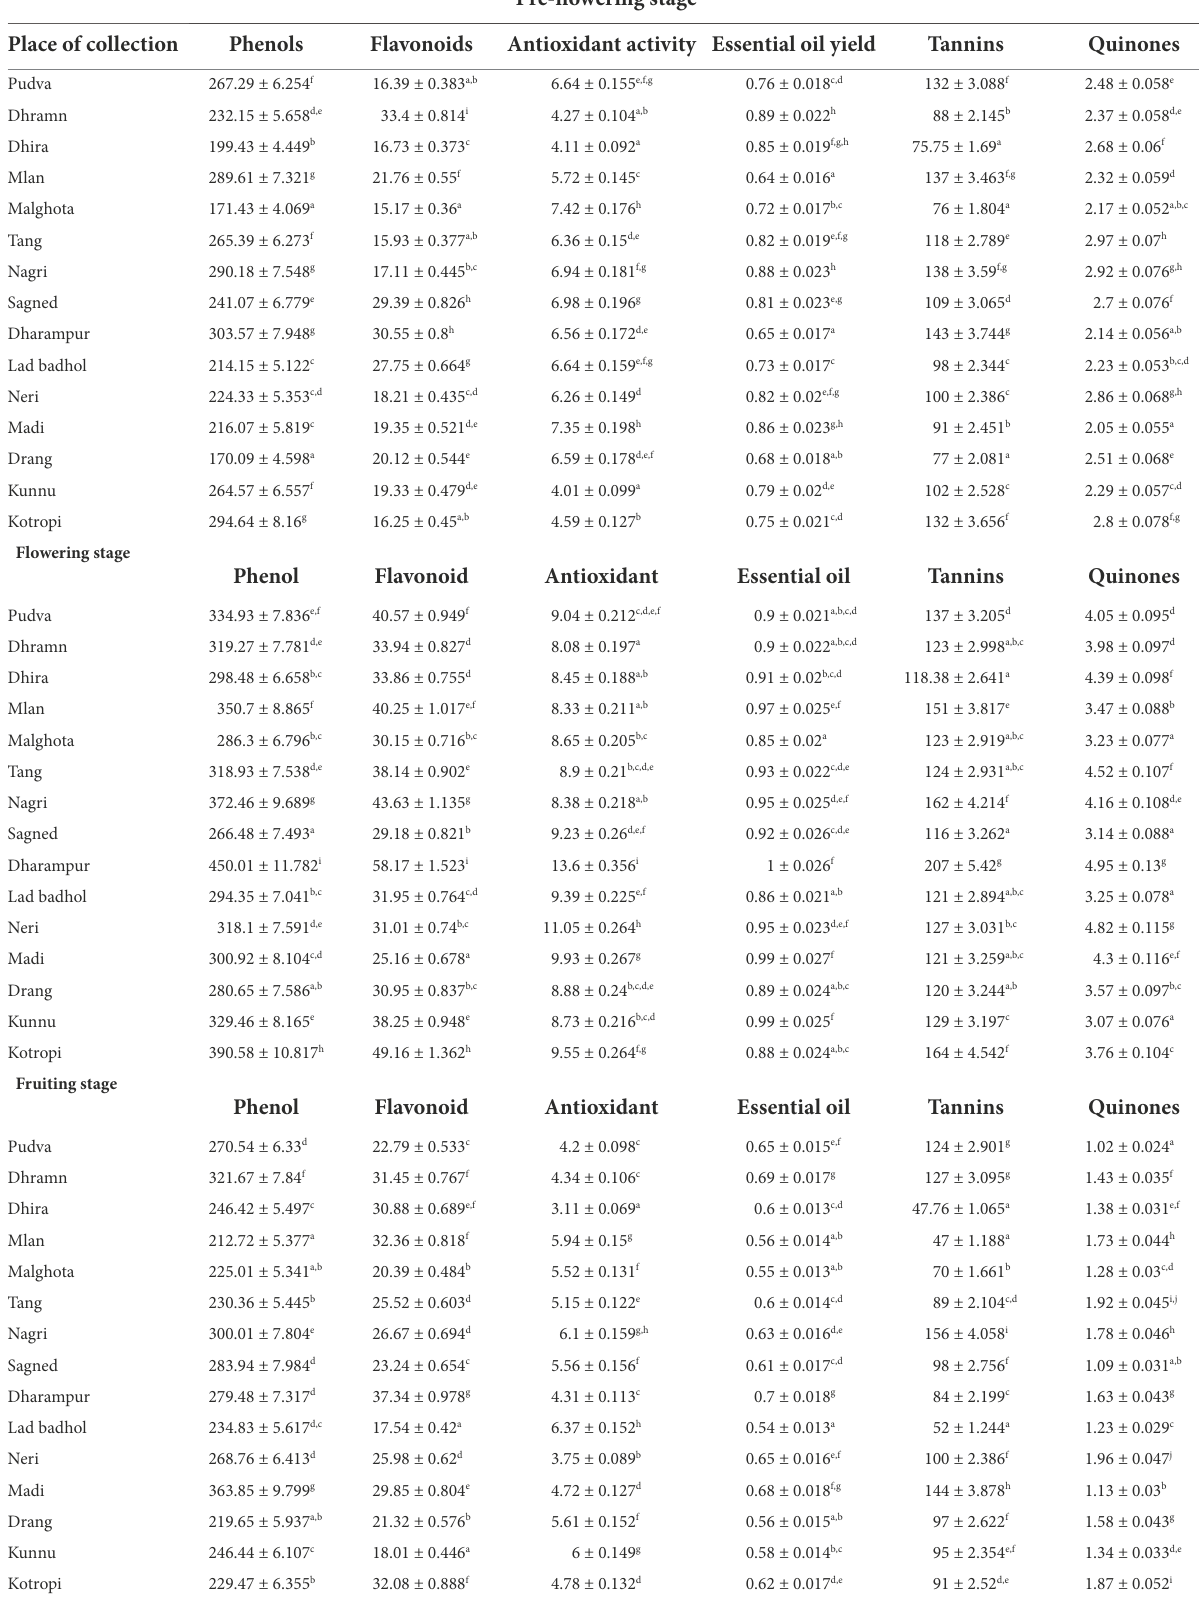
TABLE 3 Values of phytochemicals in MK leaves organized into different clusters at each growth